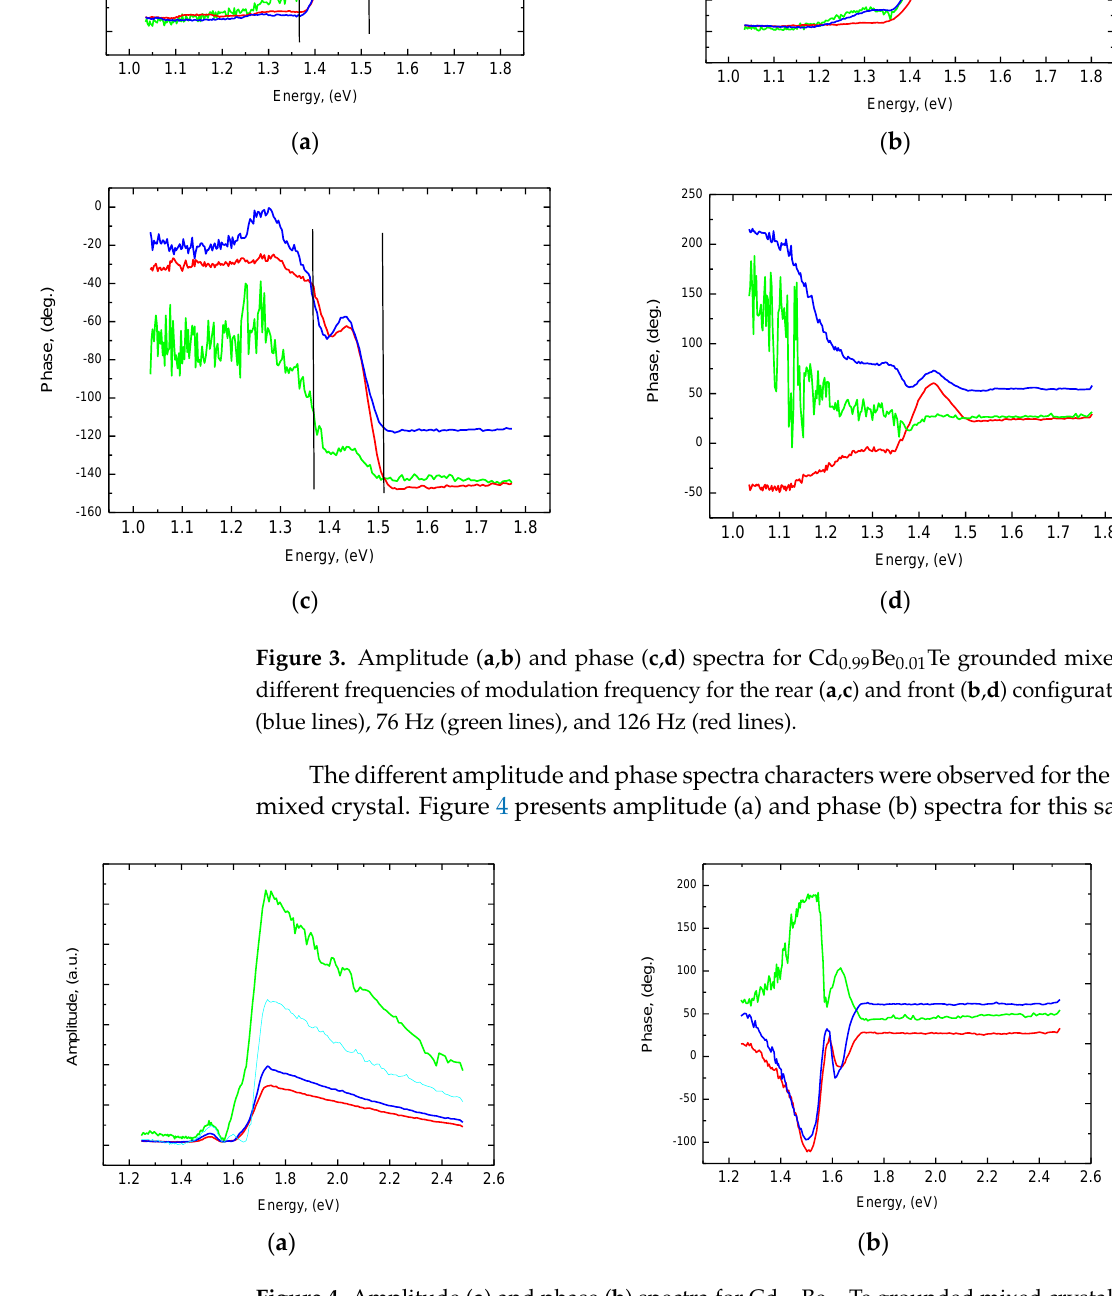
Figure 4. Amplitude ( a ) and phase ( b ) spectra for Cd 0.9 Be 0.1 Te grounded mixed crystal for different frequencies of modulation frequency for the front configuration at 12 Hz (blue lines), 36 Hz (cyan line), 76 Hz (green lines), and 126 Hz (red lines).